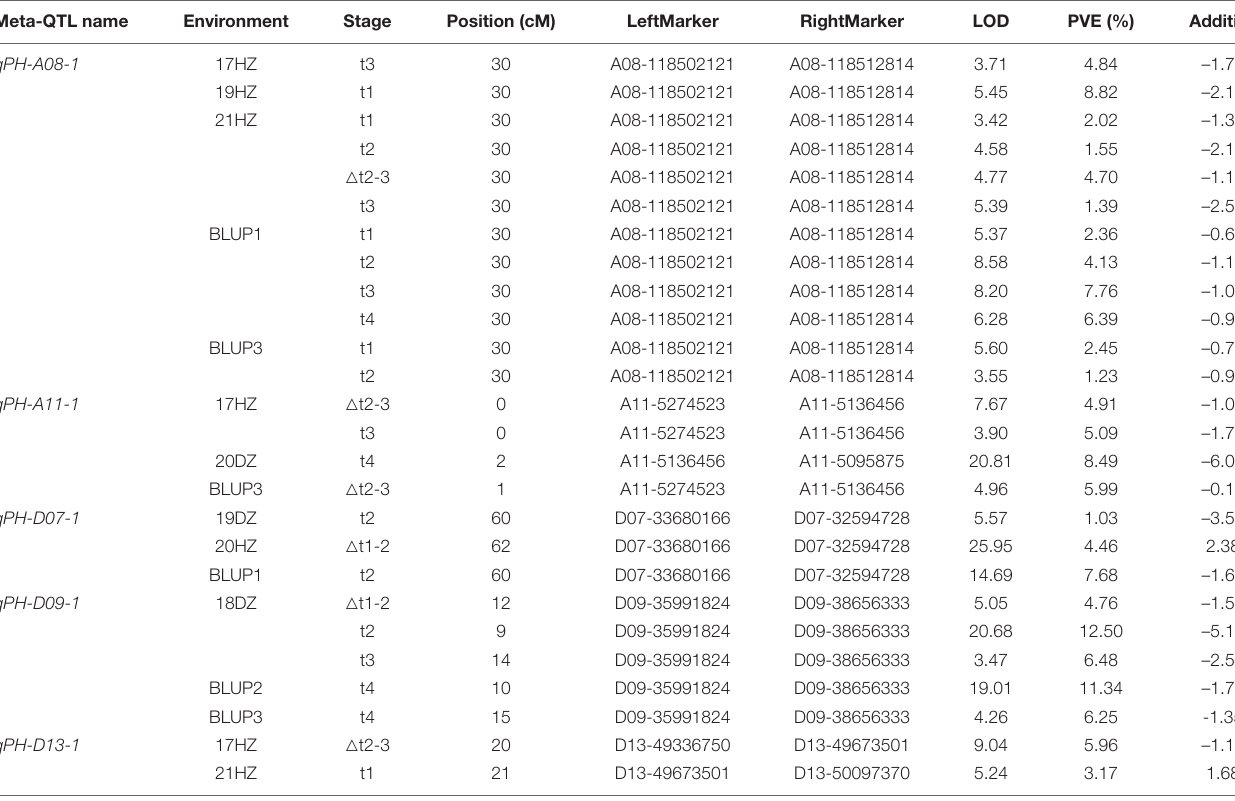
TABLE 3 | Consistent quantitative trait loci (QTL) of plant height detected in different